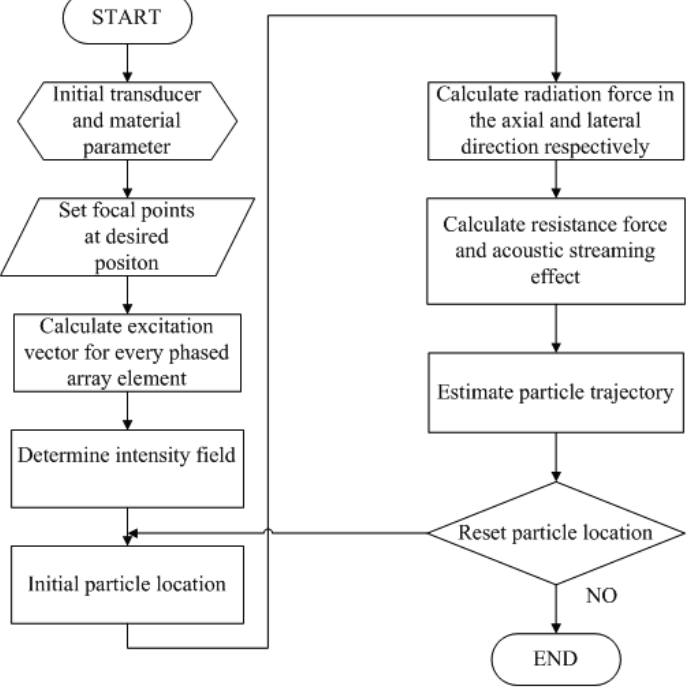
Figure 2. Flow chart for creating the multiple-focus acoustic field and calculating the radiation